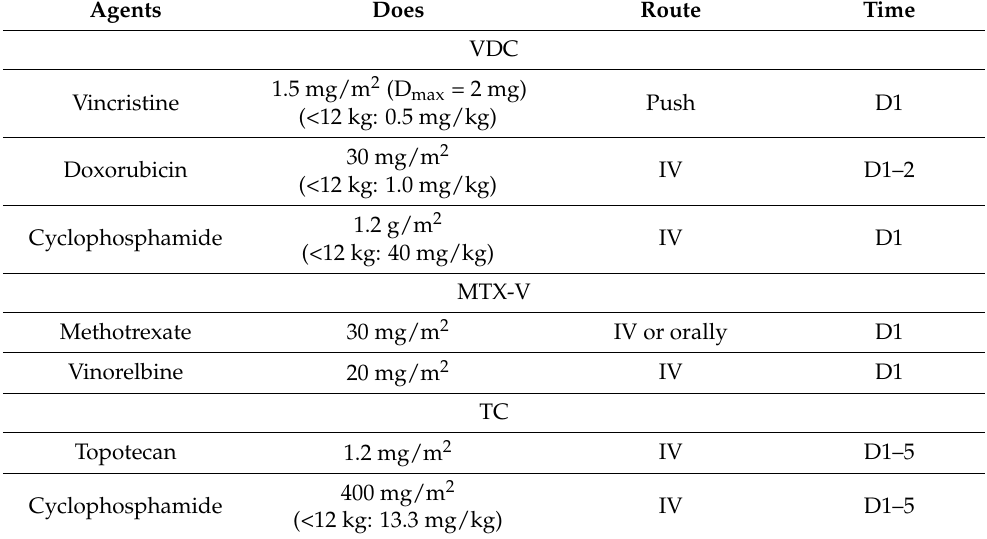
Table 3. The vincristine, doxorubicin, and cyclophosphamide (VDC) regimen, vincristine plus methotrexate (MTX-V) regimen and topotecan plus cyclophosphamide (TC) regimen. Agents Does Route Time VDC